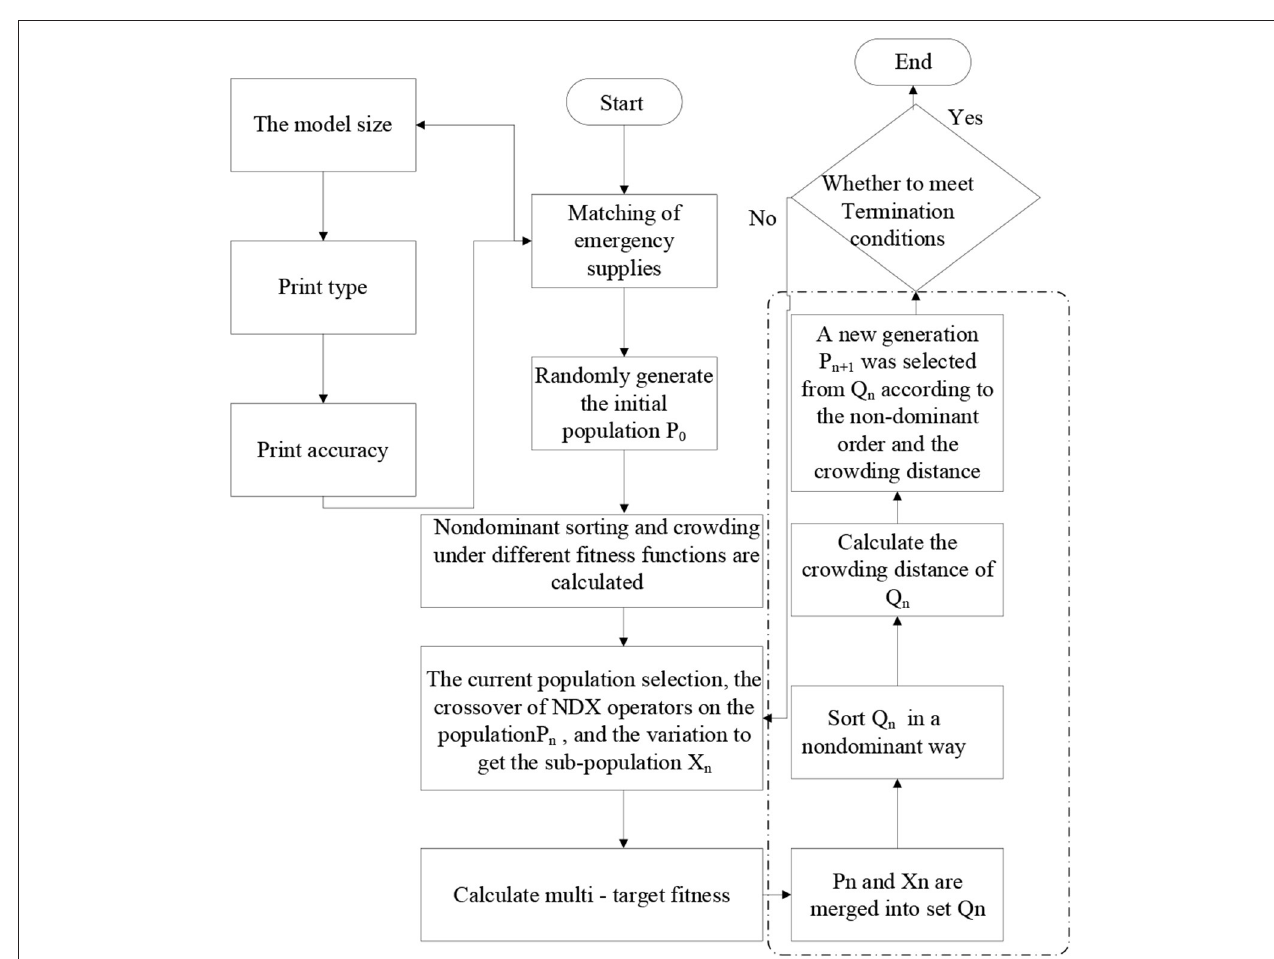
FIGURE 4 | Improved NSGA-II flow